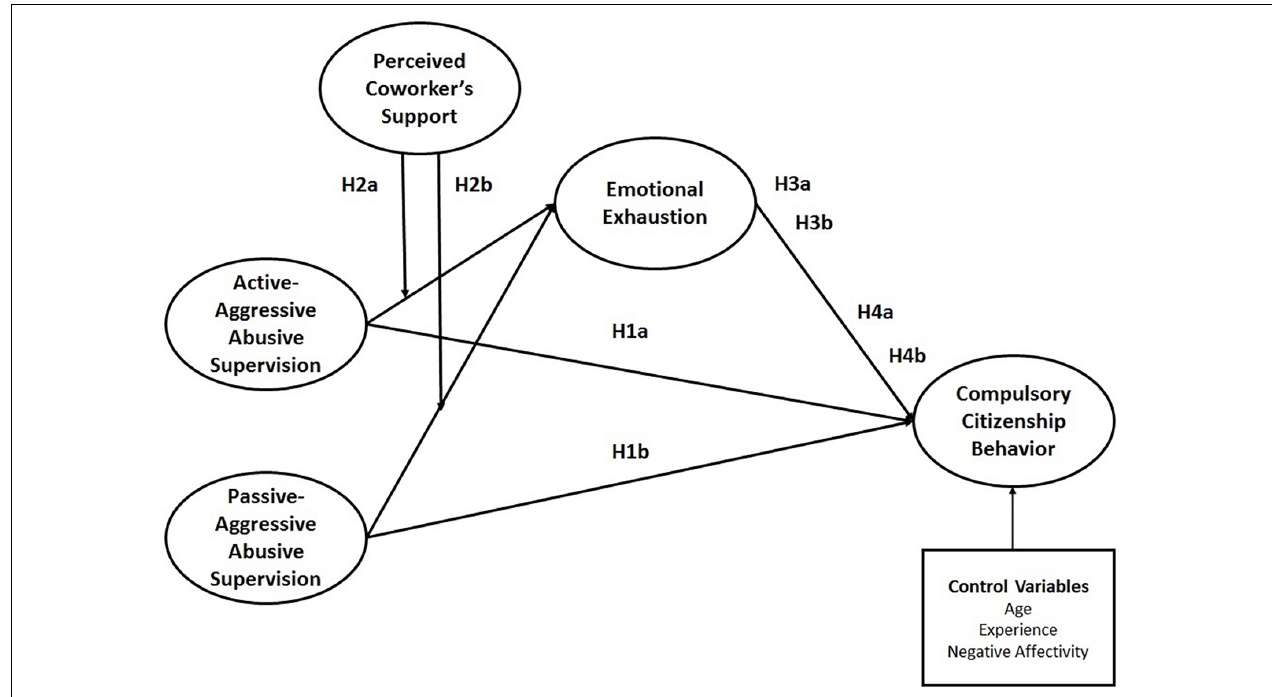
FIGURE 1 | Conceptual